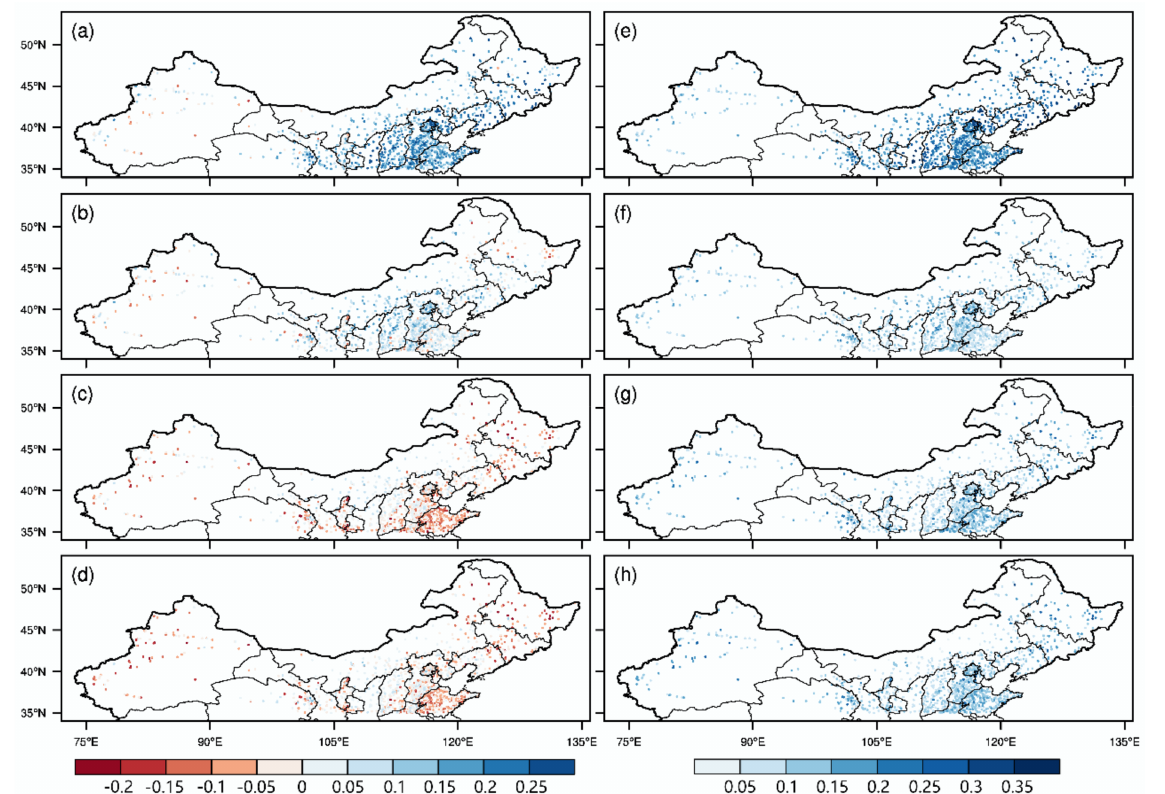
Figure 5. Spatial distributions of (left) BIAS and (right) RMSE of different soil moisture products (Unit: m 3 · m − 3 ). ( a , e ) are AMSR2 product distribution, ( b , f ) are CCI product distribution, ( c , g ) are SMAP product distribution, ( d , h ) are SMOS product